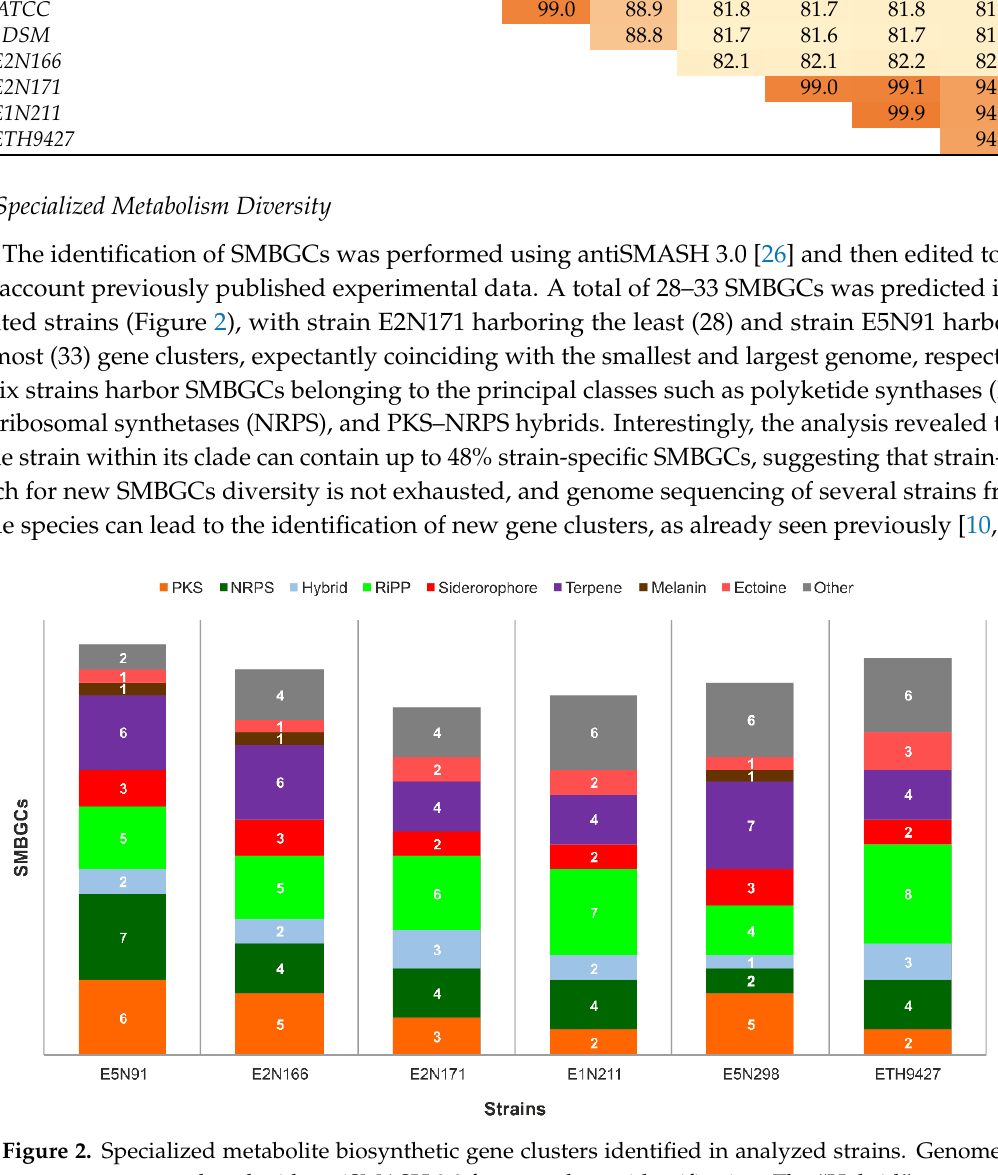
Table 2. Average nucleotide identity values of the compared strains.